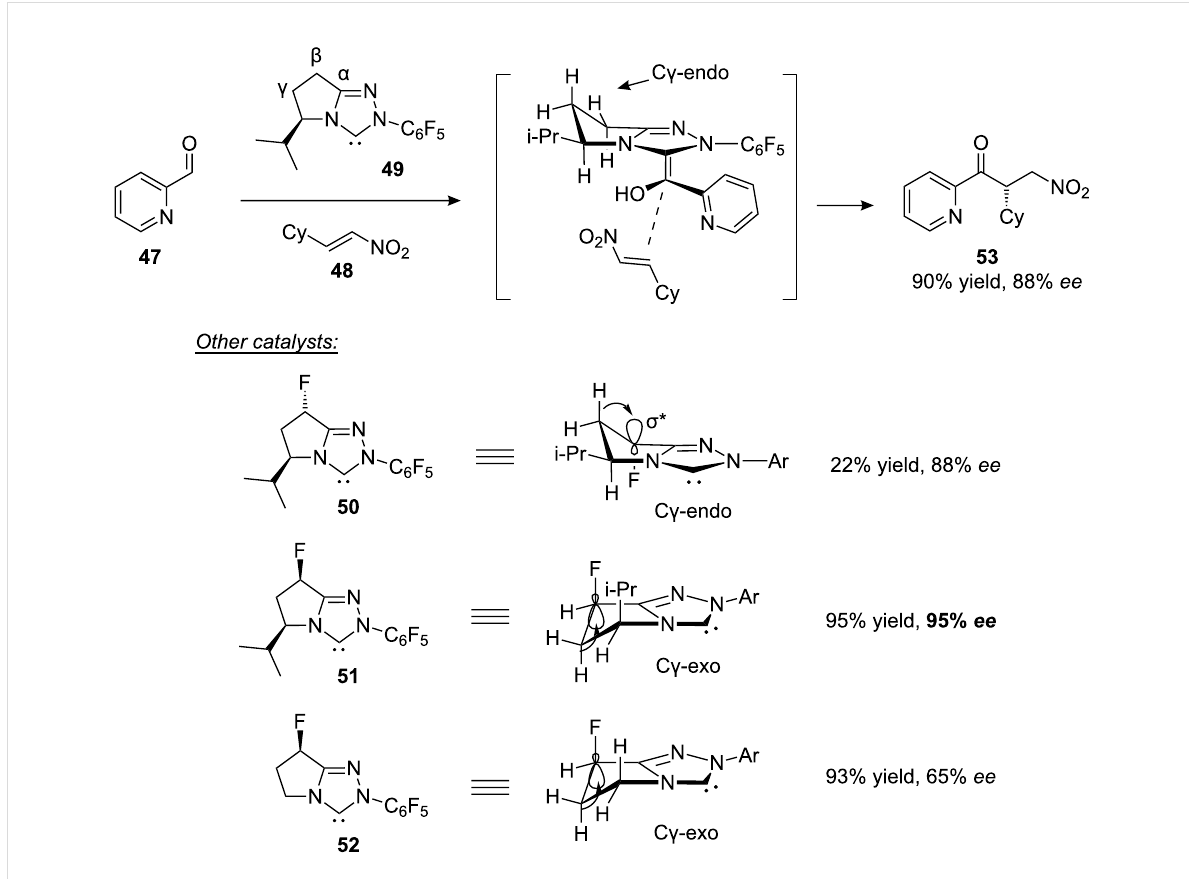
Figure 11: The asymmetric Stetter reaction catalysed by chiral NHC catalysts 49 – 52 . The ring conformations of 50 – 52 are influenced by σ CH →σ * CF hyperconjugation. Cy = cyclohexyl.